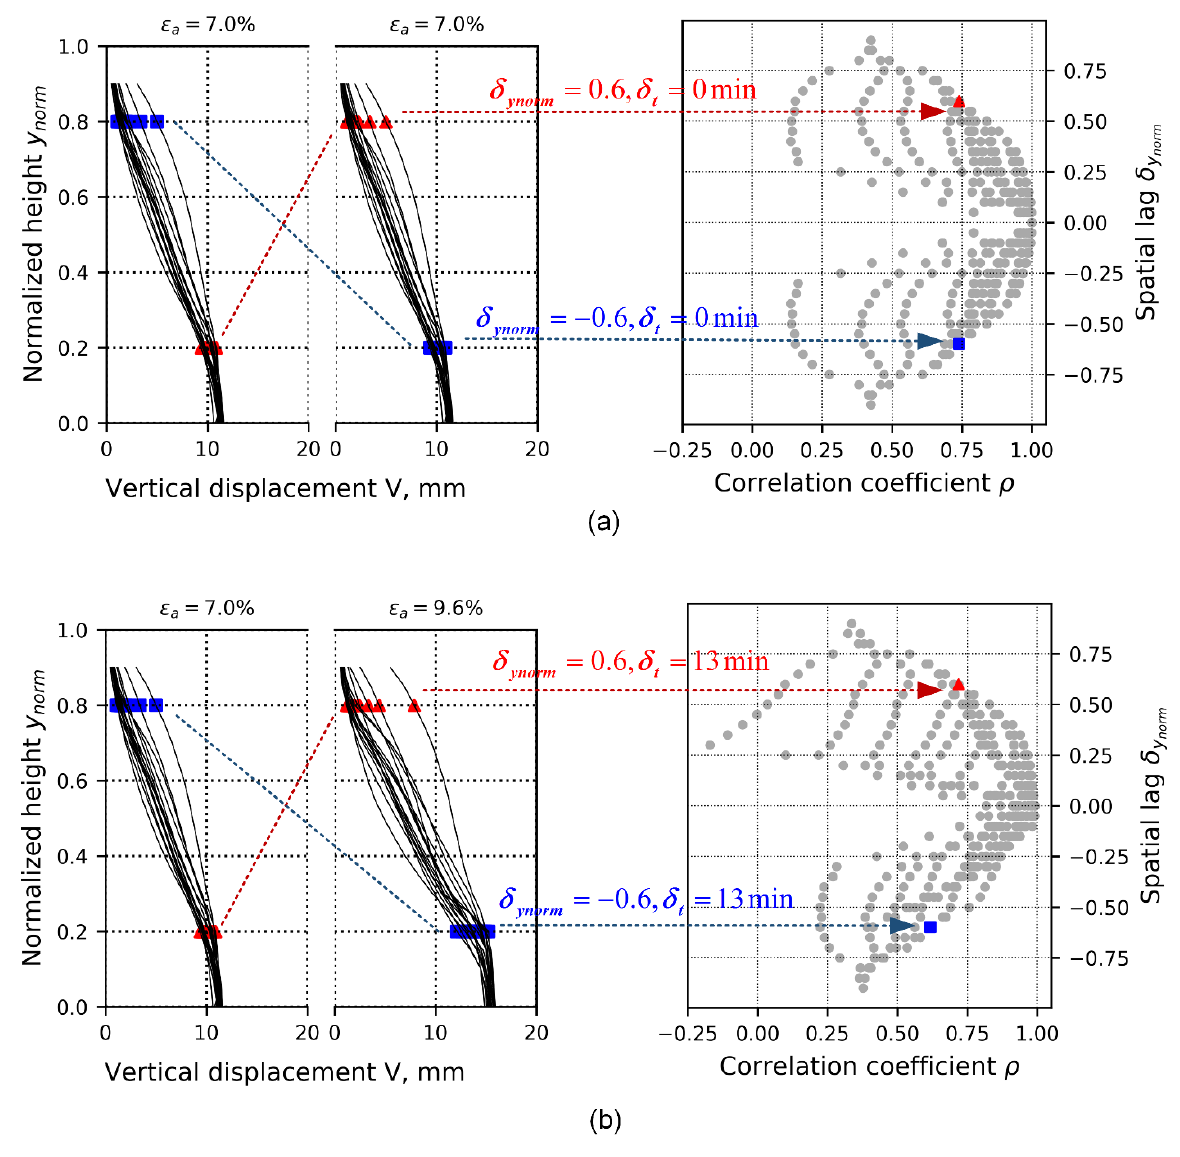
Figure 7. Cases illustrating computing correlation coefficients toward the 1D-T vertical displacement field. ( a ) Calculation of auto-correlations of data ensemble at loading stage of 7.0% of axial strain. Red triangles represent the computing case that has positive spatial lag, and blue squares represent the computing case that has negative spatial lag. The resulting correlation coefficients are plotted against spatial lags along the vertical profile of the specimen. ( b ) Calculation of cross-correlations of data ensembles at loading stages of 7.0 and 9.6% of axial strain. The procedure is similar to that of Figure 6a, except that time lag, δ t , is non-zero and needs to be interpreted from two loading stages.